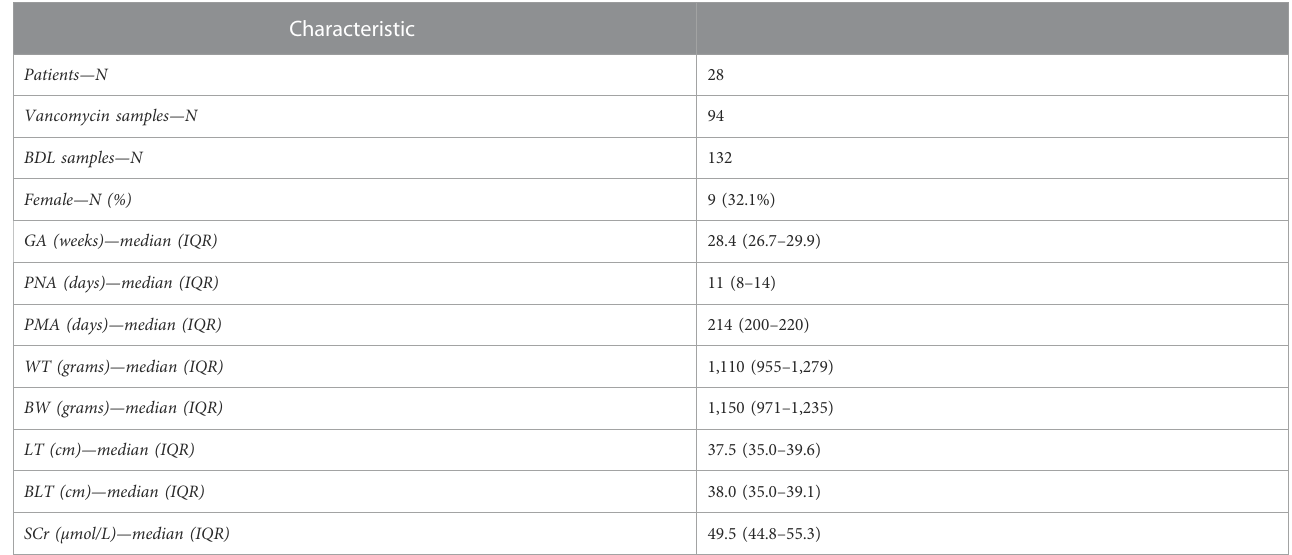
TABLE 1 Demographic characteristics of the study